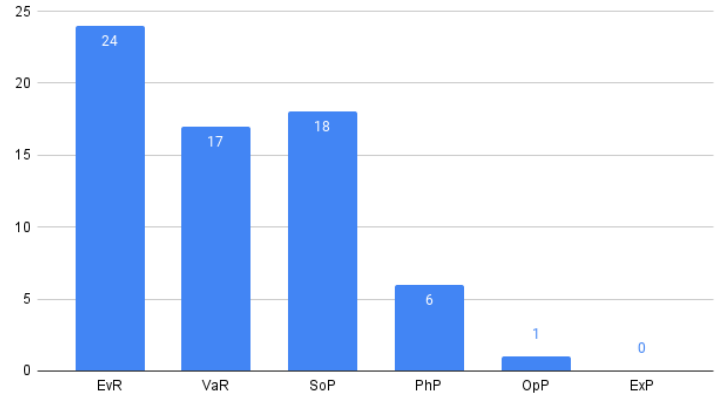
Figure 10. Validation of the